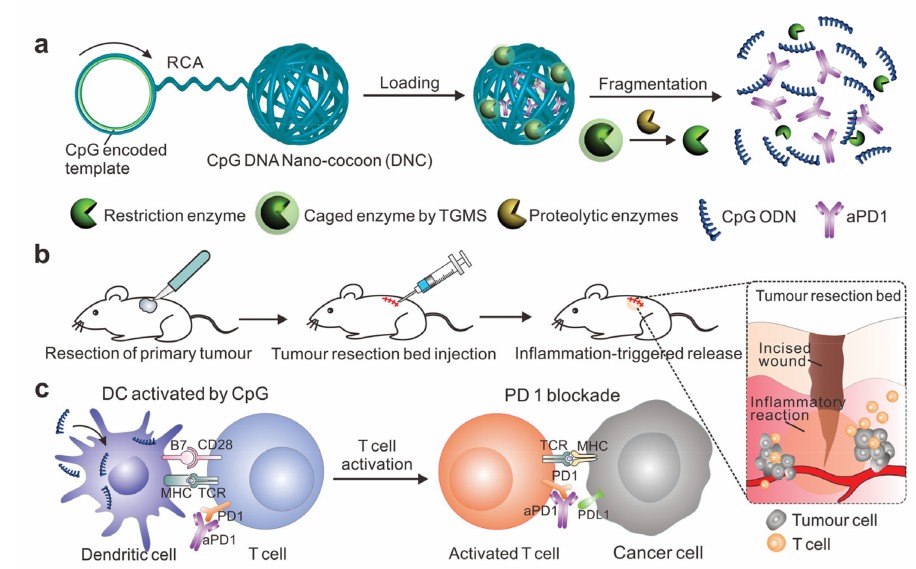
Figure 7. Schematic illustration of ( a ) aPD1 and caged restriction enzyme loaded DNA nanococoon (DNC), ( b ) In vivo tumor immunotherapy after primary tumor resection, local injection, and treatment of DNC-based delivery system and ( c ) Activation of DCs by CpG which in turn activates T cell response with aPD1 for PD 1 blockade. Reproduced with permission from [127]. Copyright 2016, WILEY-VCH Verlag GmbH & Co. KGaA,